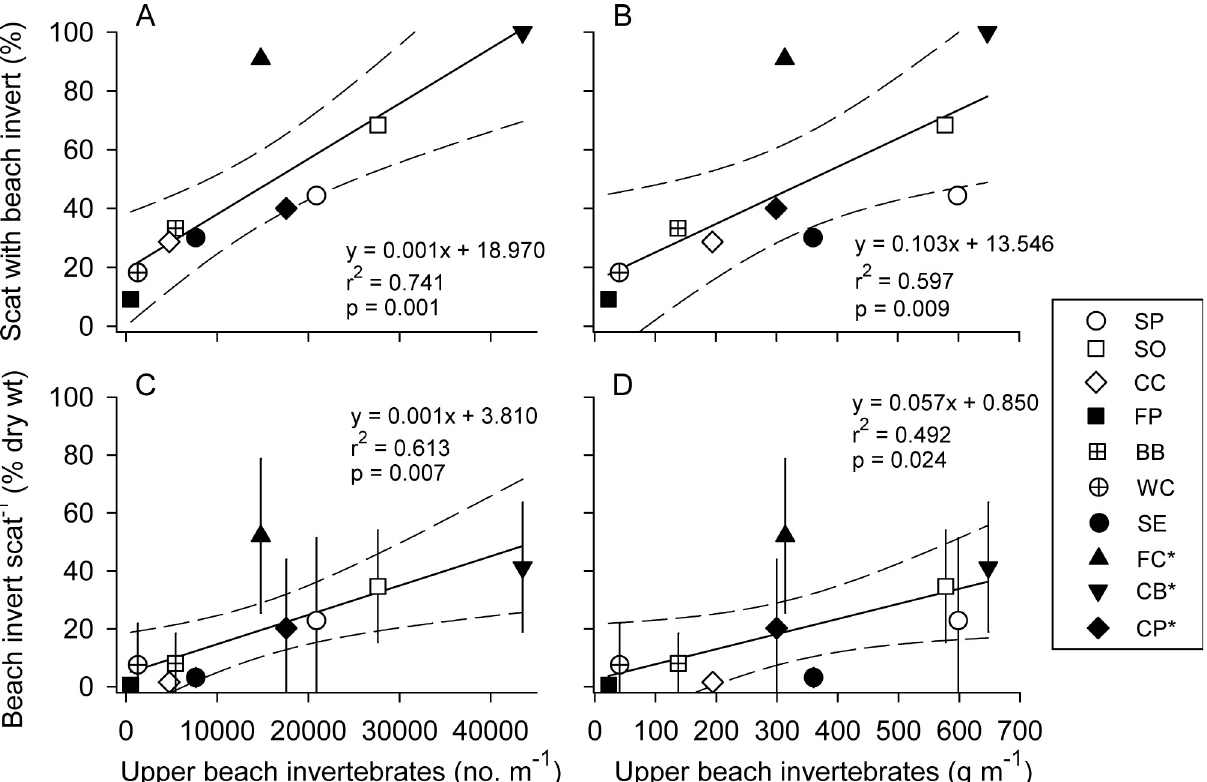
Fig 4. Relationships between beach material in scats and endemic beach invertebrate abundance and biomass. Proportion (as percent) of scat with endemic beach invertebrates and (A) invertebrate abundance and (B) biomass, and mean percent of invertebrates per gram scat versus (C) invertebrate abundance and (D) biomass at Santa Rosa and Santa Cruz Island study sites. Mean values for (C) and (D) ± 95% confidence intervals. Regression fits weighed for differences in sample size among sites. Dashed lines show 95% confidence intervals around regression lines. Site abbreviations as in Fig 1. � Santa Cruz